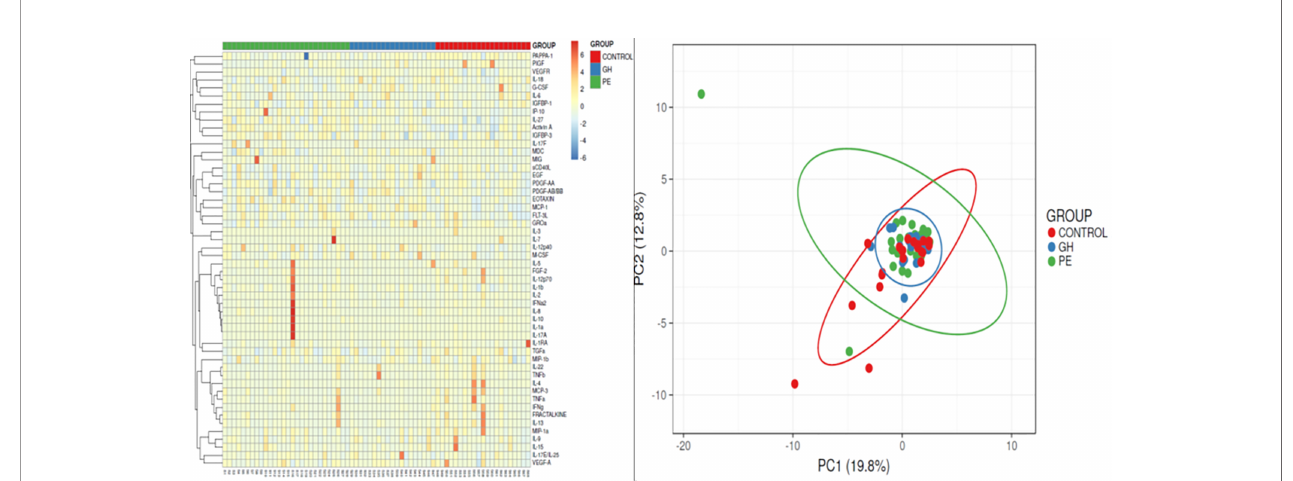
FIGURE 2 | Screening with heatmap and